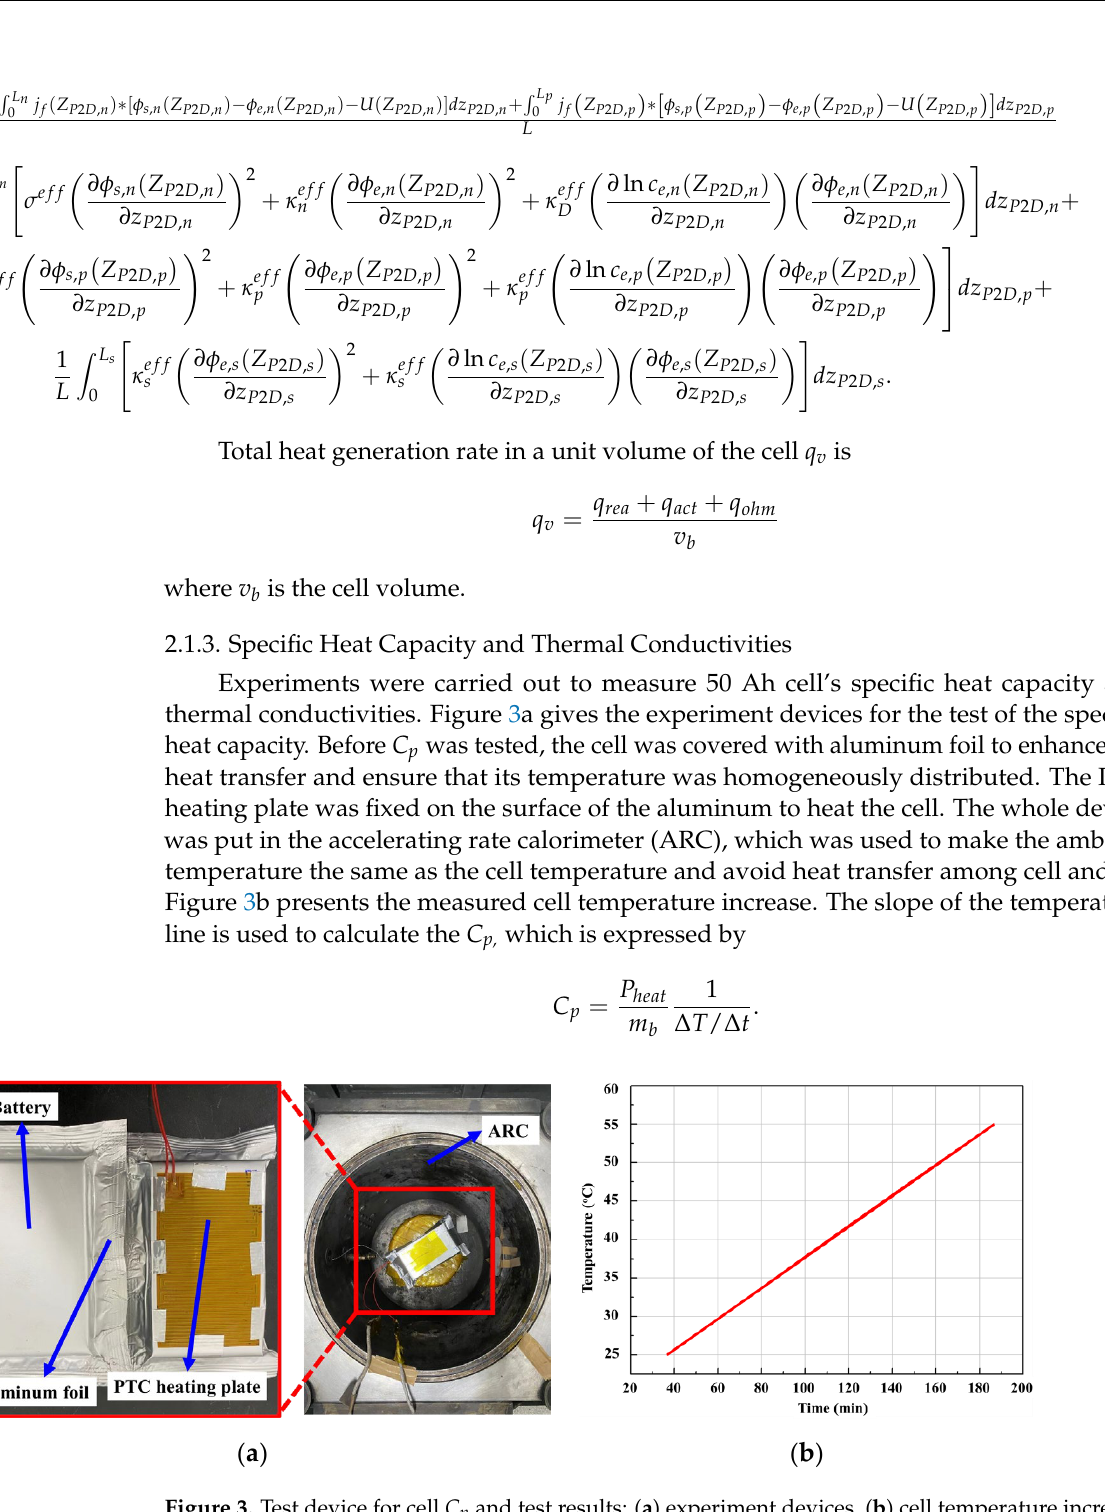
Figure 3. Test device for cell C p and test results: ( a ) experiment devices, ( b ) cell temperature increase.